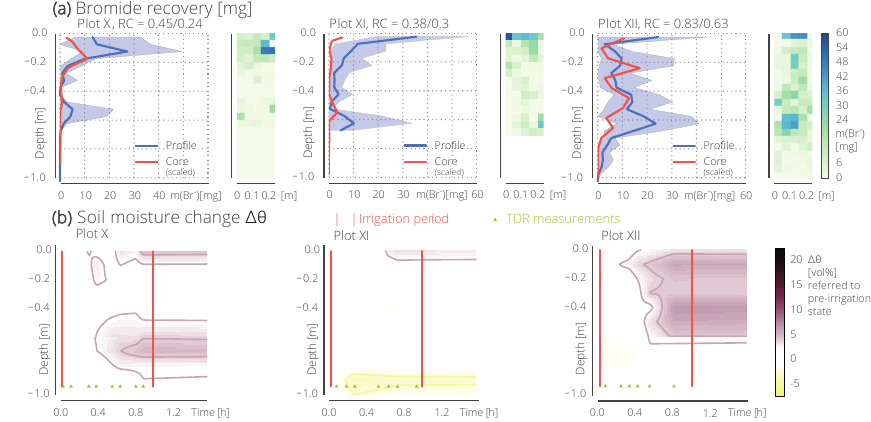
Figure 7. Results from plot-scale irrigation experiments with 50, 30, and 50mm spray irrigation for 1h. (a) Recovered bromide mass profiles and grids (5 × 5cm). Blue line as mean and shaded area between min/max for each depth of the sampling grid. Orange line is the mass recovered in drilled profile samples (scaled to the same volume reference). Recovery coefficient (RC) calculated for the profile samples (first value) and the profile and core samples (second value). (b) Observed soil moisture change referenced to the first measurement shortly before onset of the irrigation. Individual measurement times marked with